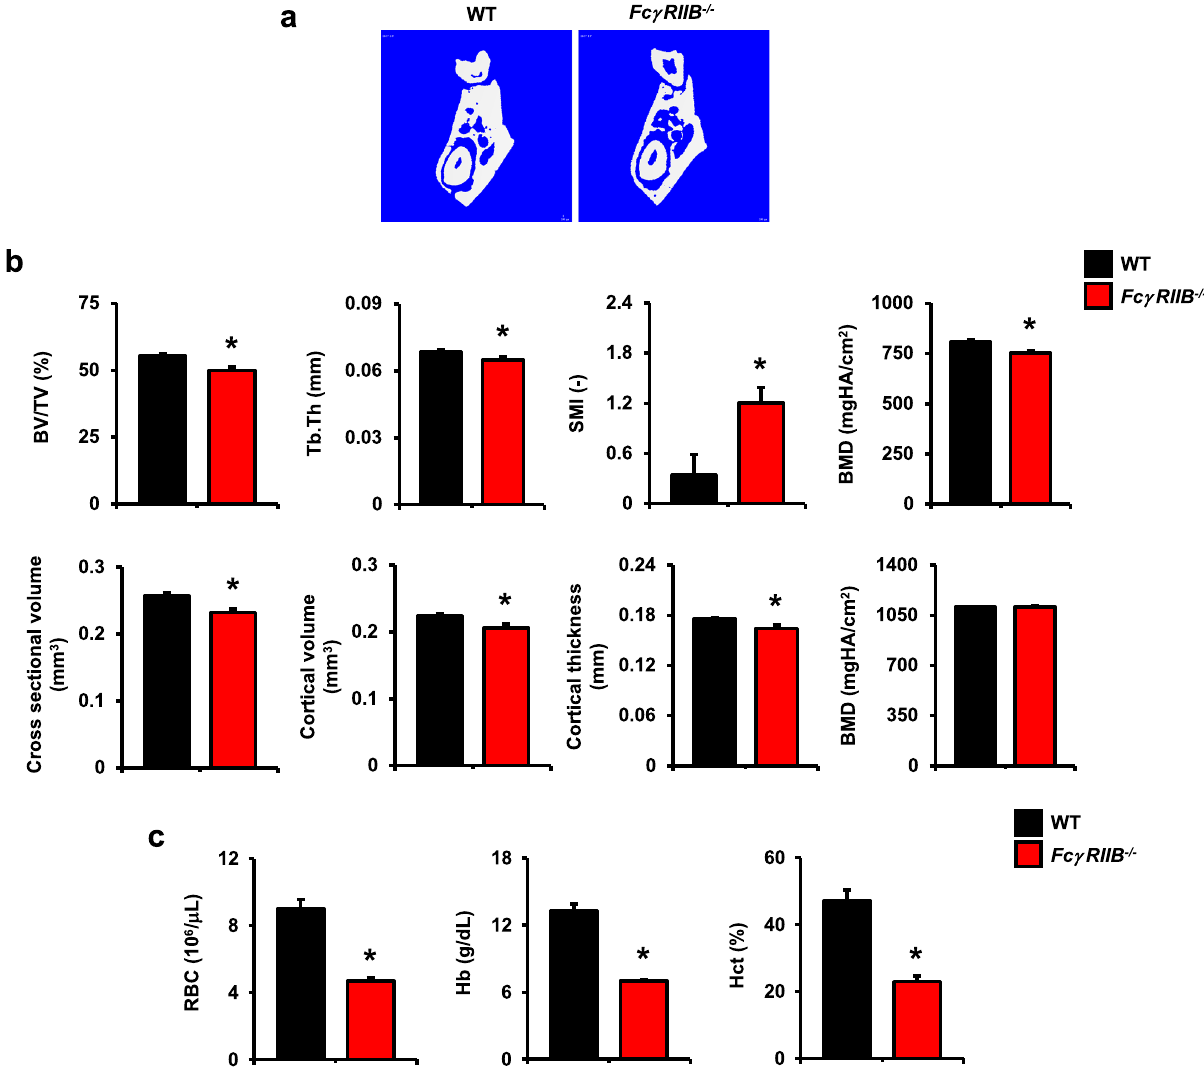
Figure 1. Ablation of FcγRIIB in mice induced mandibular bone loss and anemia. ( a ) Representative µCT images of the mandibles from 6-month-old FcγRIIB -/- males compared to WT controls. ( b ) μCT analysis of cancellous bone (upper) and cortical bone (lower) at the first molar of the left mandible from FcγRIIB -/- mice ( n = 8) compared to WT controls ( n = 6). ( c ) Complete blood count (CBC) analysis of 6-month-old FcγRIIB -/- mice ( n = 3) compared to WT controls ( n = 4). Data are mean ± SEM. * p < 0.05 compared to WT controls. BV/ TV; bone volume per tissue volume, Tb.Th; trabecular thickness, SMI; structural model index, BMD; bone mineral density, RBC; red blood cells, Hb; hemoglobin, and Hct; hematocrit. WT FcγRIIB -/- (n = Parameters